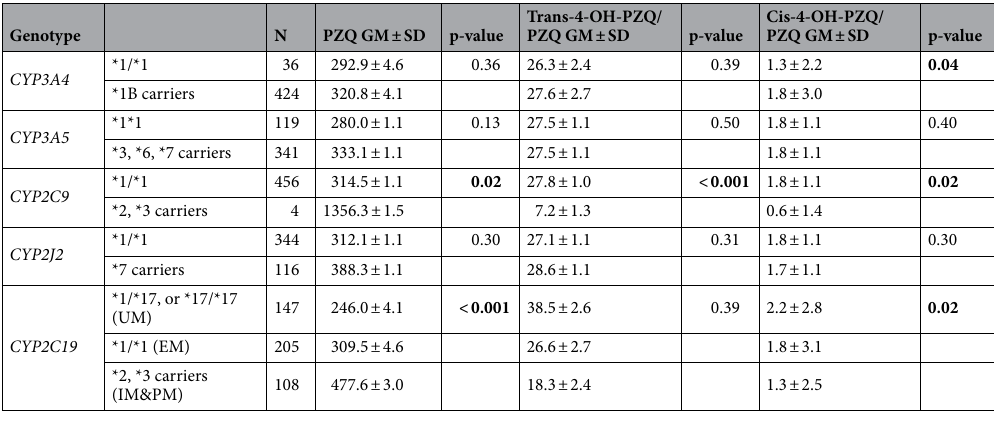
Table 2. Comparison of the geometric means of PZQ concentration (ng/mL) and metabolic ratios trans -4- hydroxy-praziquantel/praziquantel and cis -4-hydroxy-praziquantel/praziquantel between CYP450 genotypes. GM geometric mean, OH hydroxyl, PZQ Praziquantel, SD standard deviation, UM ultra-rapid metabolizers, EM extensive metabolizers, IM intermediate metabolizers, PM poor metabolizers. Significant values are in bold.